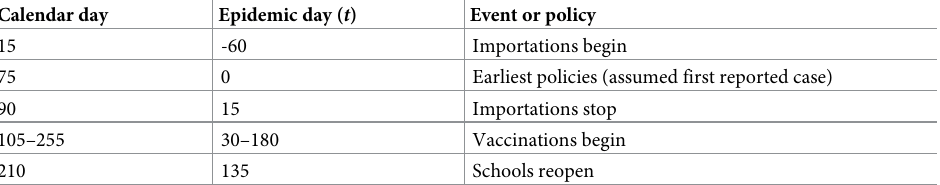
Table 2. Summary of events and policy implementation dates in model. Calendar day 0 = January 1,